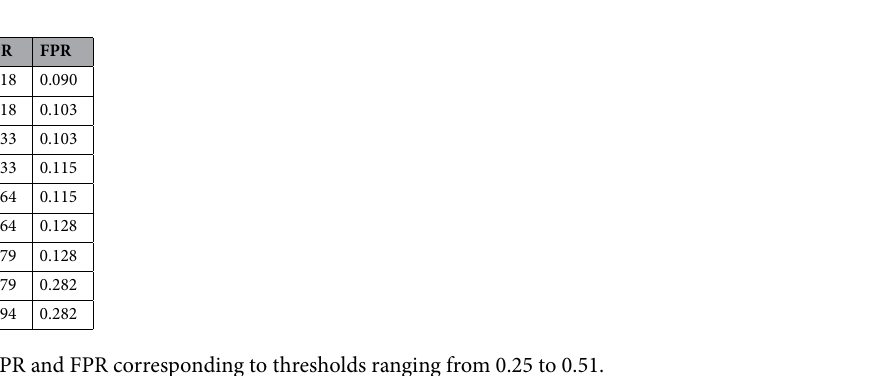
Table 5. The TPR and FPR corresponding to thresholds ranging from 0.25 to